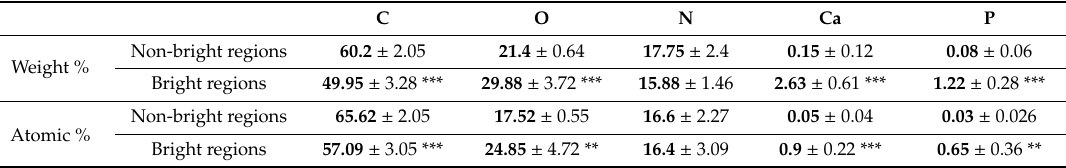
Table 3. Results (mean ± SD) of weight and atomic percentages of C, O, N, P, Ca in the bright